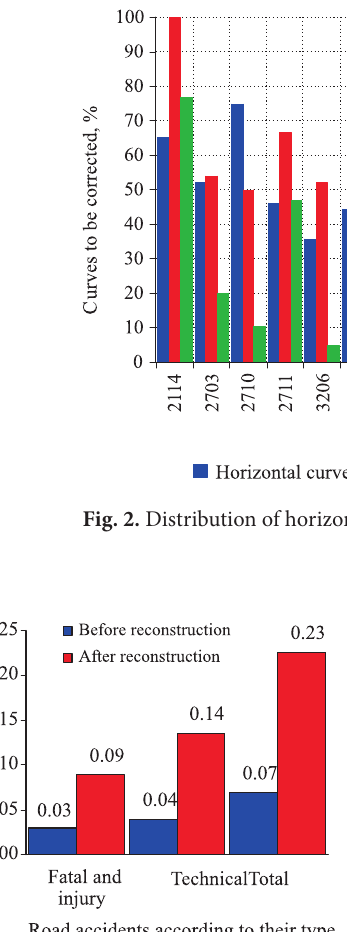
Fig. 3. Comparison of accident density of each type of accidents before and aft er reconstruction of gravel roads under the supervision of SE Telšių regiono keliai